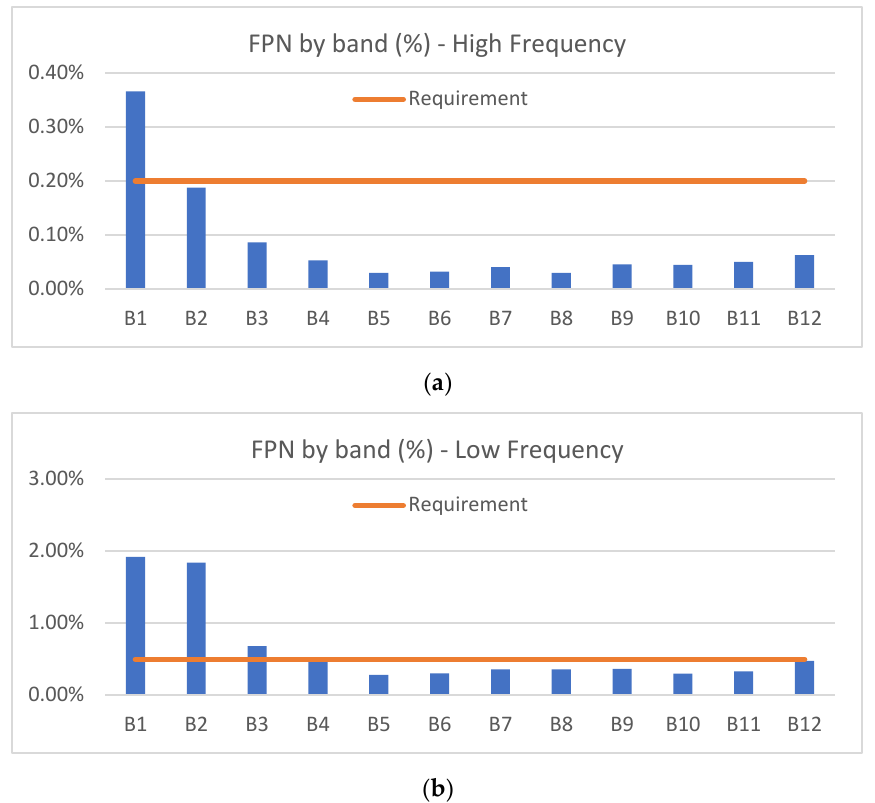
Figure 11. ( a ) High-frequency FPN estimation for all spectral bands; ( b ) low-frequency FPN estima- tion for all spectral bands.